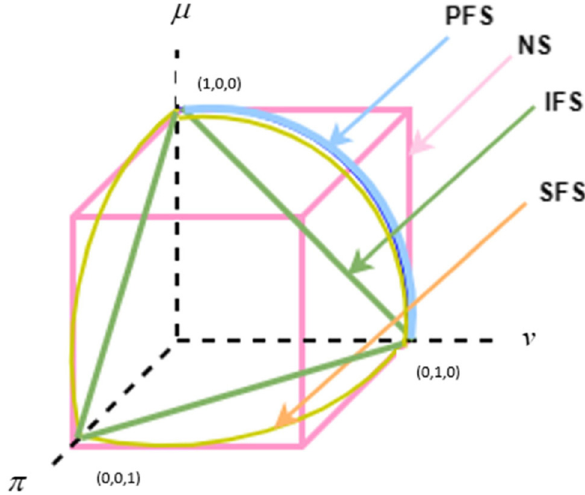
Figure 4: IFS, PFS, NS, and SFS geometric illustrations [ 38 ]